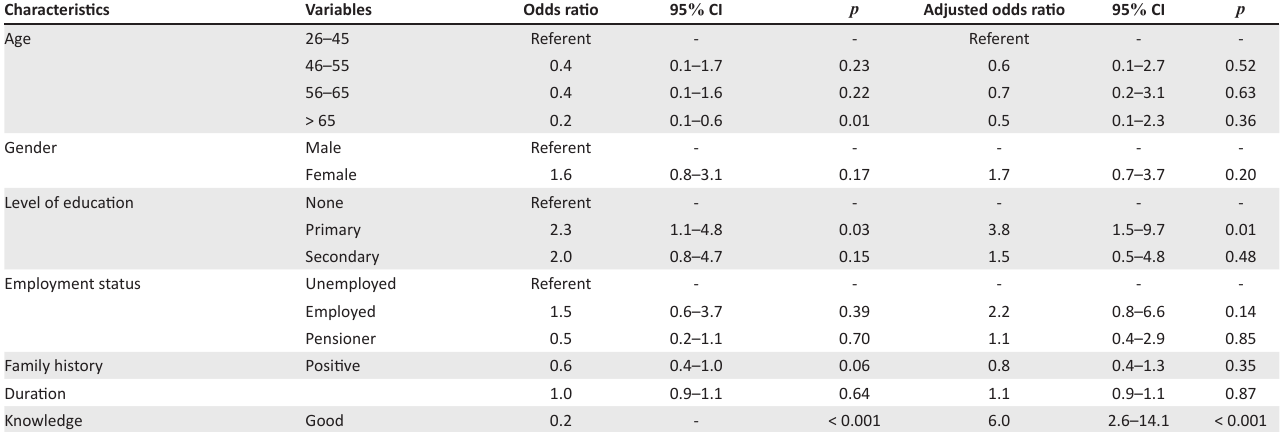
TABLE 4: Patient-related characteristics associated with patients’ glaucoma self-care practices in the uThungulu Health District, 2016–2017. Characteristics